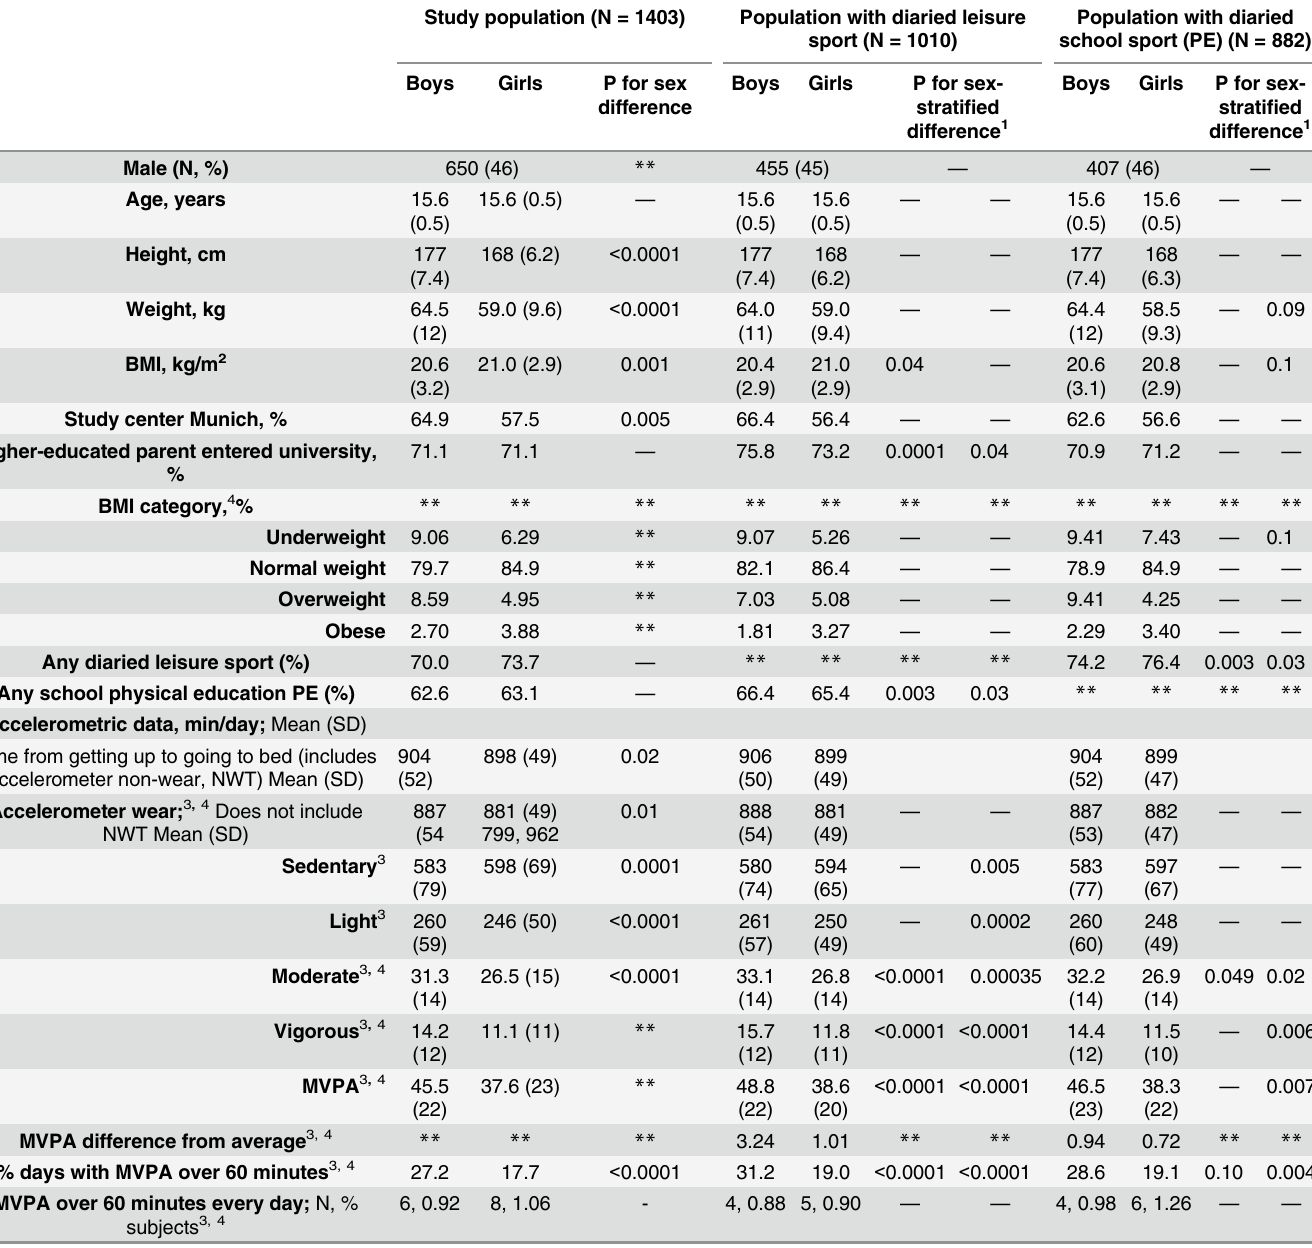
Table 2. Population Characteristics and Selection.